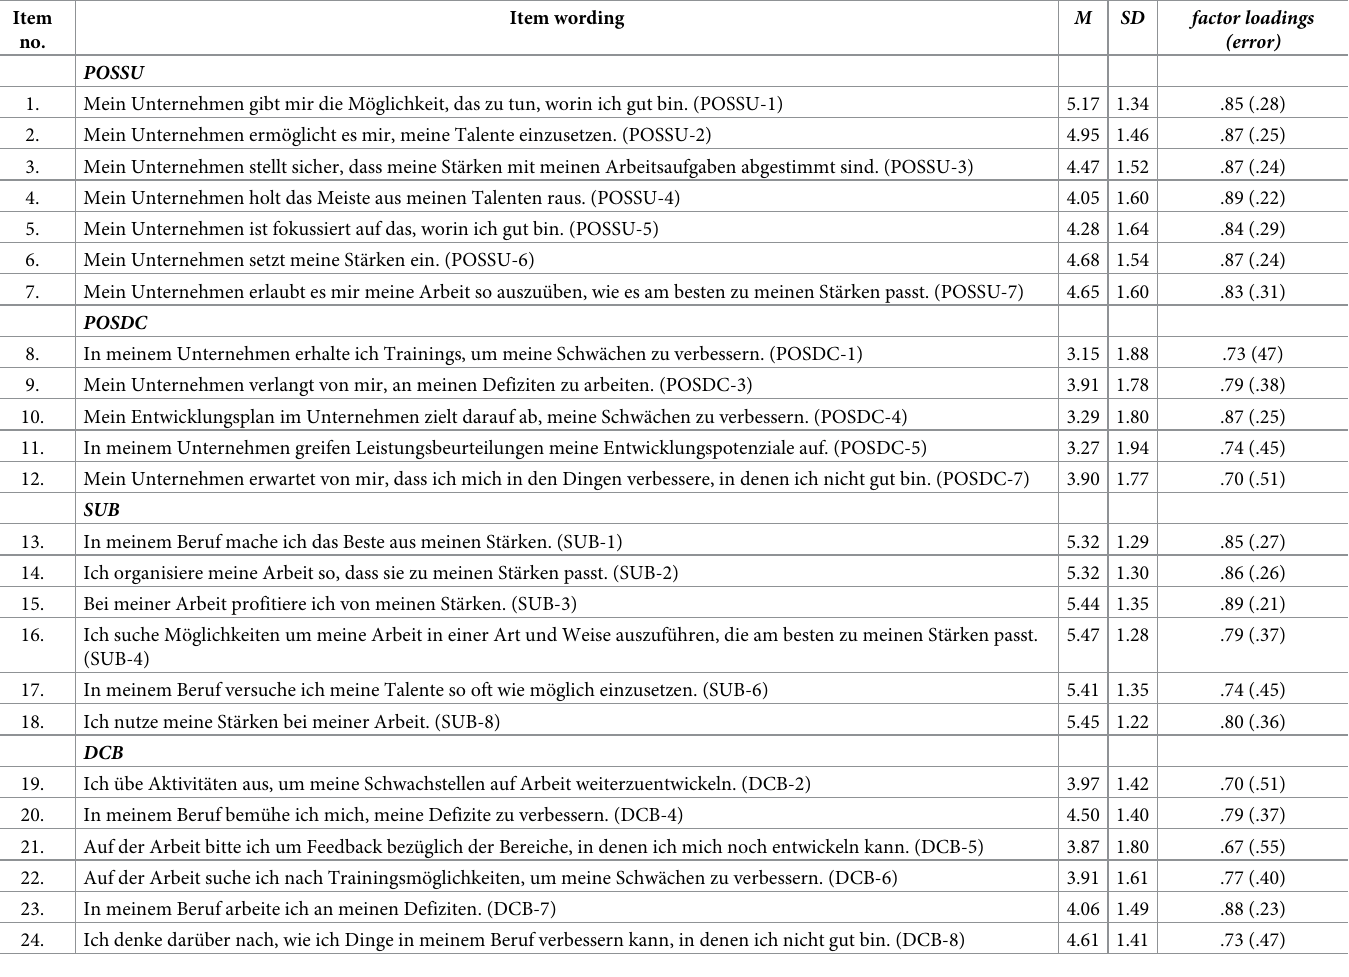
Table 2. Factor loadings of all items of the SUDCO-G for Study 1. Item